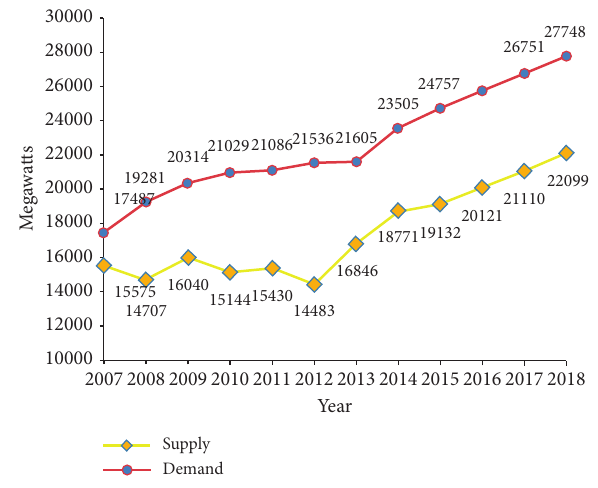
Figure 1: Electric power demand and supply in Pakistan [10].